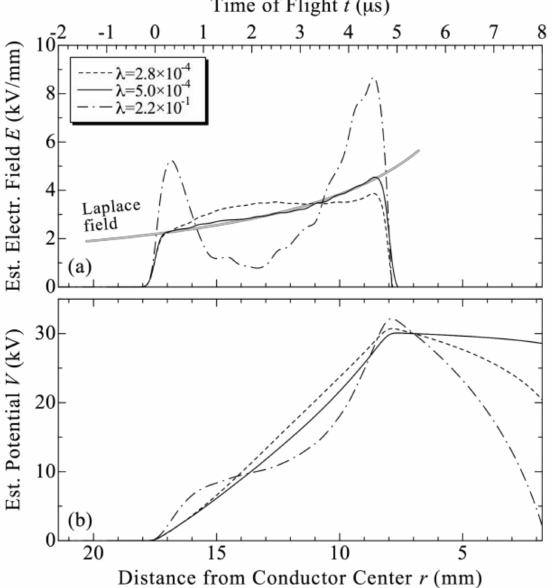
Figure 6. Estimated electric field ( a ) and potential ( b ) obtained by integrating the charge distribution shown in Figure 5a. The gray curve in ( a ) shows the field distribution calculated from Laplace’s equation. This curve was extrapolated to the inner and outer semiconductive layer areas to increase